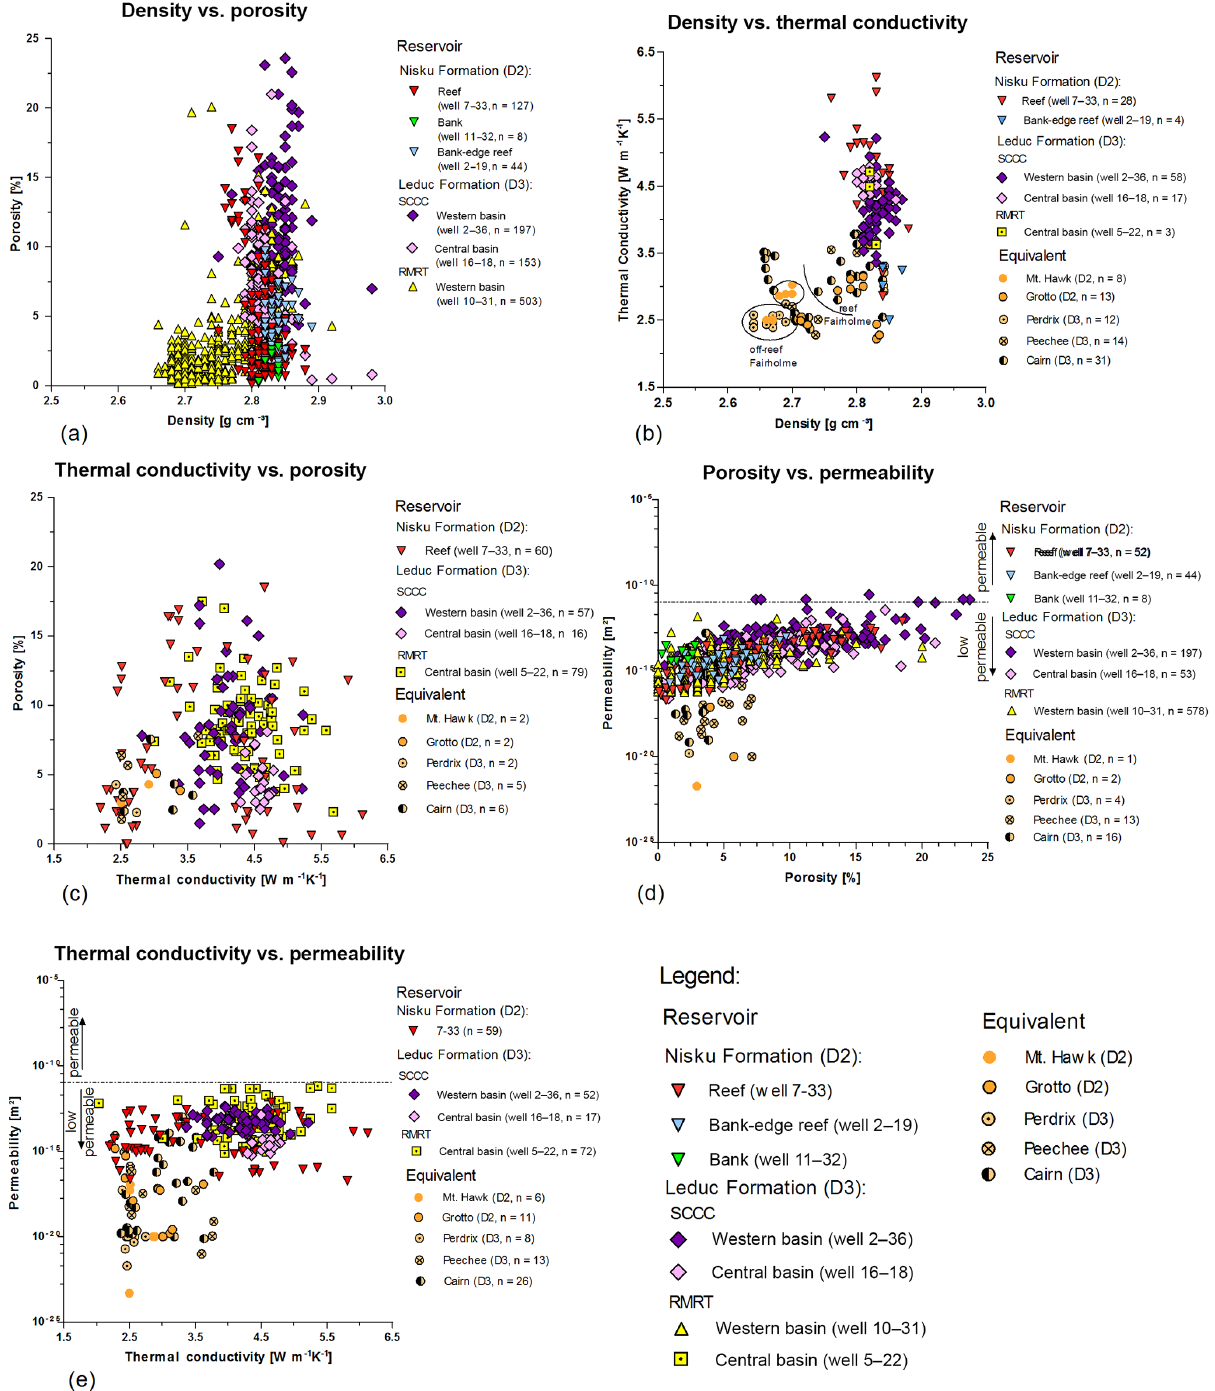
Figure 8. Correlation of petrophysical and thermophysical rock parameters analyzed at dry conditions.